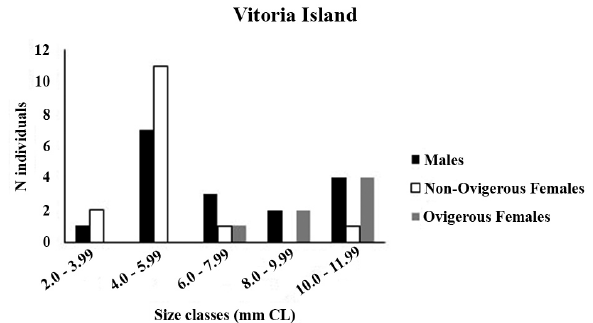
Figure 6. Size-class distribution of Alpheus formosus individuals collected at Vitoria Island, São Paulo State,